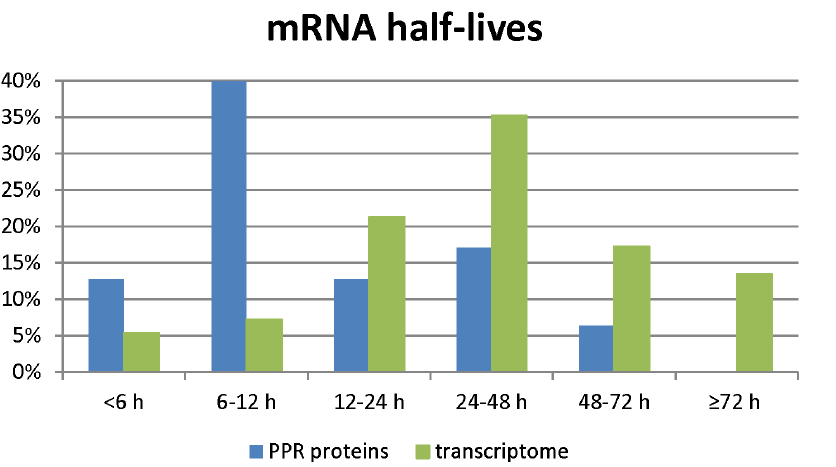
Figure 5. mRNA half-live distributions for pentatricopeptide repeat (PPR) protein transcripts. mRNA half-lives were calculated for 47 of the 93 features annotated as PPRs on the array. mRNA half-lives were binned on time and distributions are shown for these PPR transcripts. The distribution of 7086 features of the K. brevis transcriptome are re-plotted from figure 3 for ease of comparison.